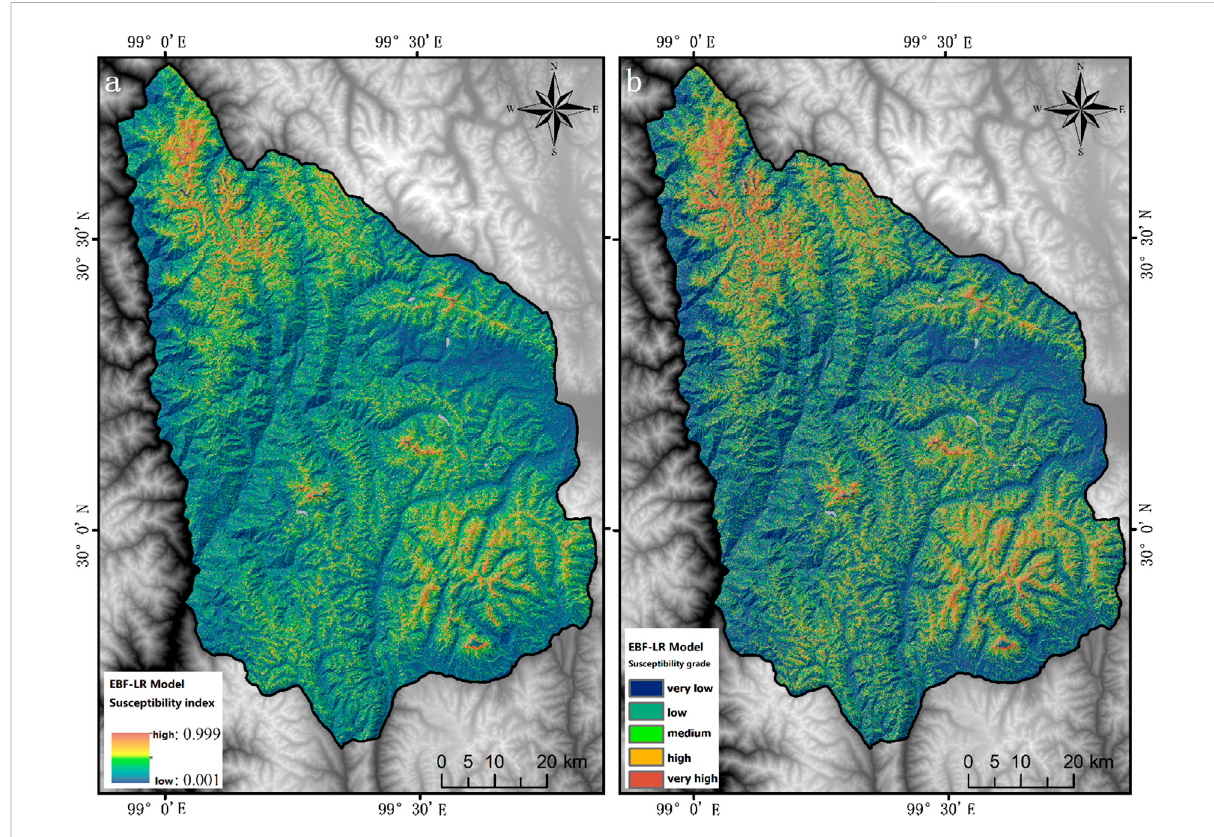
FIGURE 7 EBF-LRmodelsusceptibilityzoningmap (A) ;EBF-LRmodelsusceptibilityzonationmapwassegmentedbythenaturaldiscontinuitymethod (B)